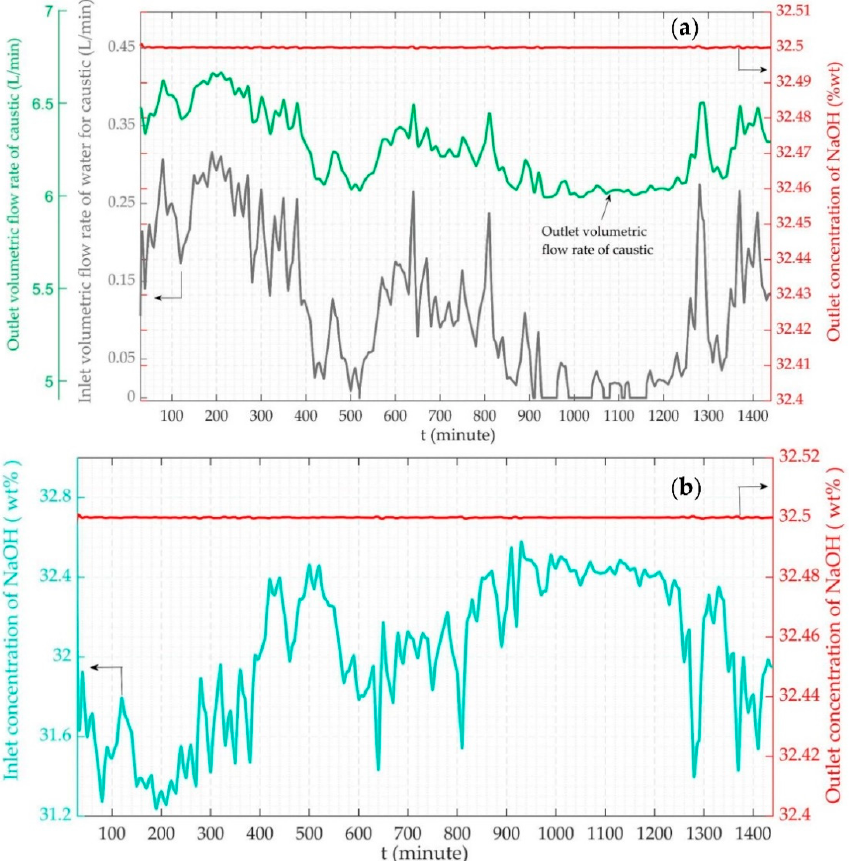
Figure 13. Dynamic response of ( a ) the outlet caustic concentration (controlled variable), inlet volumetric flow rate of water for caustic (manipulated variable), the resulting outlet volumetric flow rate of caustic and ( b ) the inlet caustic concentration at the cathode compartment. Operating conditions: temperature: T in cat = 85 ◦ C; and anolyte concentration: X in = 300 gL − 1 an, NaCl